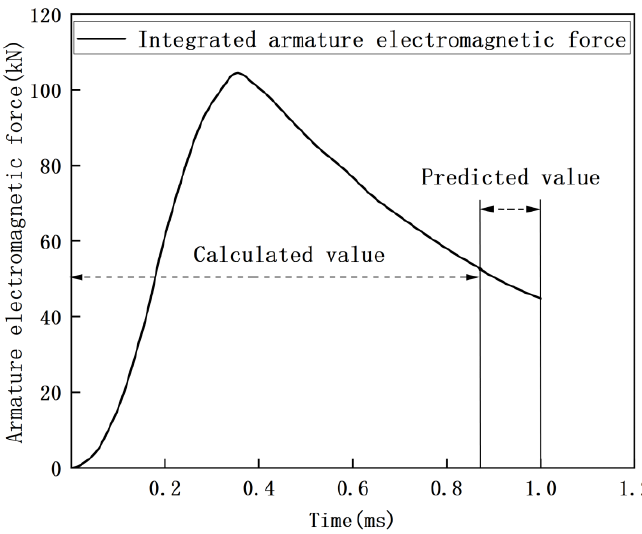
Figure 13. Integrated armature electromagnetic force under standard armature conductivity in case 1.